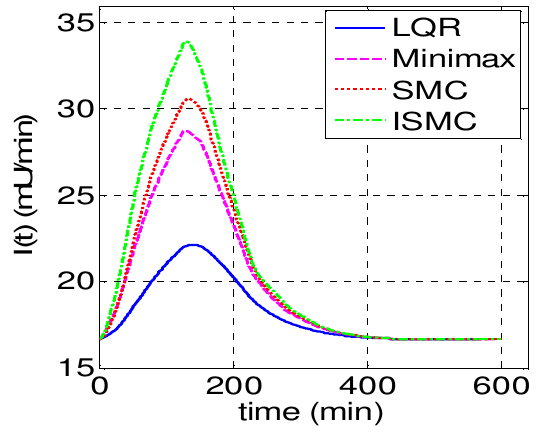
Fig. 6. Plasma glucose